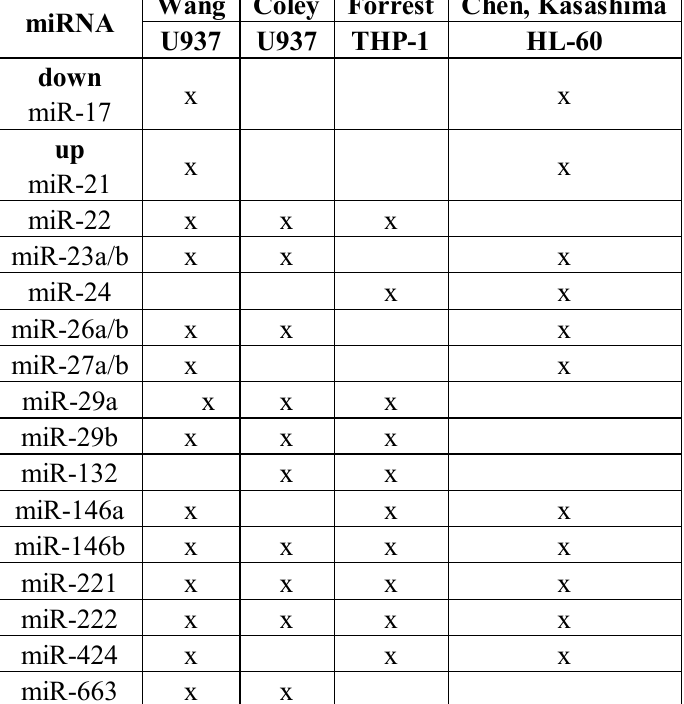
Table 1. Commonly reported regulated miRNAs: U937, THP-1, HL-60 differentiation. Results of five studies of PMA-induced U937, THP-1, or HL-60 monocyte